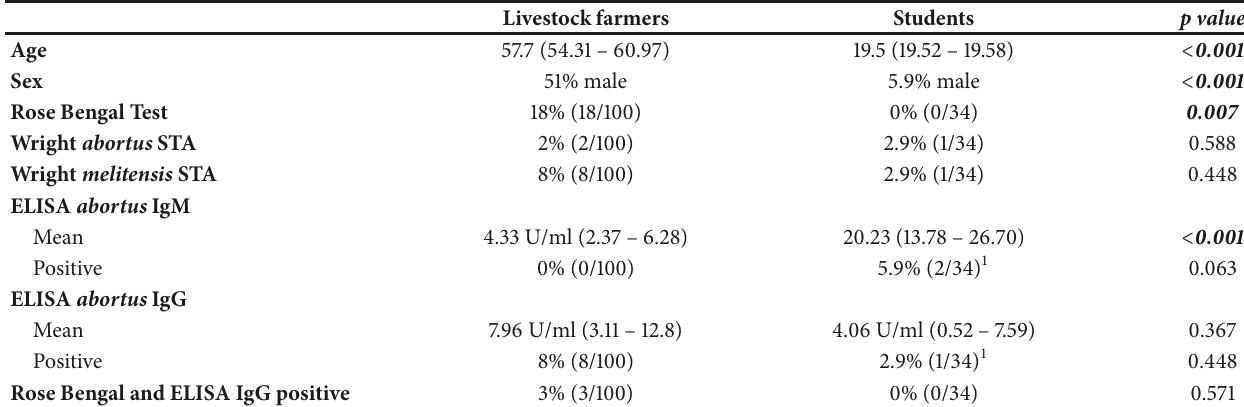
Table 1: Serology results in high- and low-risk populations.